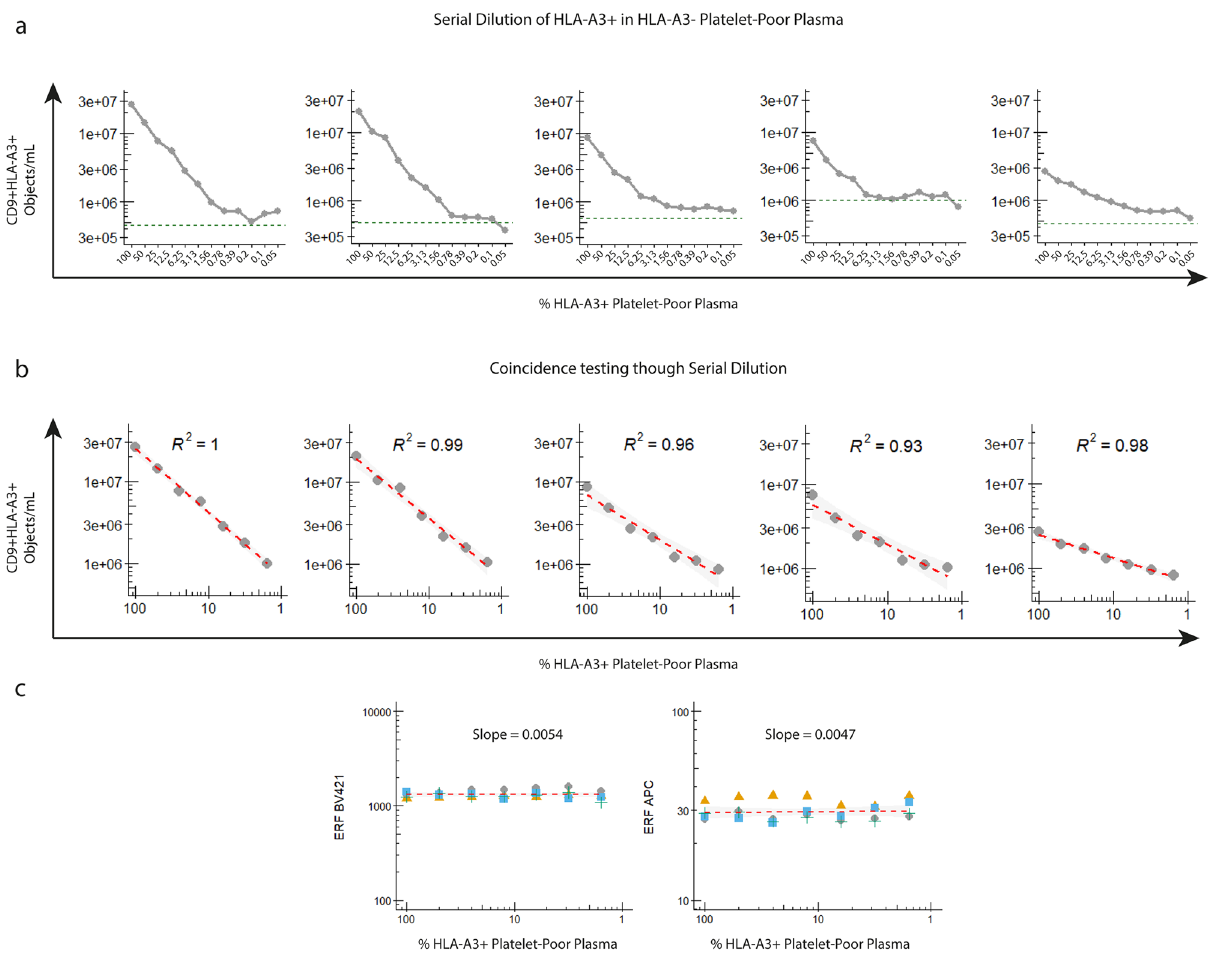
Figure 3. Quantification of CD9 + HLA-A3 + events in mixed PPP samples. ( a ) Serial dilutions (twofold) of 5 double-stained (anti-CD9 and anti-HLA-A3) matched donor-recipient samples shows that our setup is able to discriminate CD9 + HLA-A3 + EVs above recipient ‘self’ background (HLA-A3- recipient signals, indicated by the green dashed lines) down to ~ 1%. ( b ) Coincidence testing through serial dilution. A linear correlation between the concentrations of CD9 + HLA-A3 + EVs and dilution factor (range: 100% to 1.56% HLA-A3 + PPP) for each serial dilution experiment confirmed single particle analysis in mixed PPP samples. ( c ) Stable (standardized) fluorescent signals for both detection channels (Ch01 – HLA-A3 / Ch05 – CD9) were observed irrespective of the dilution